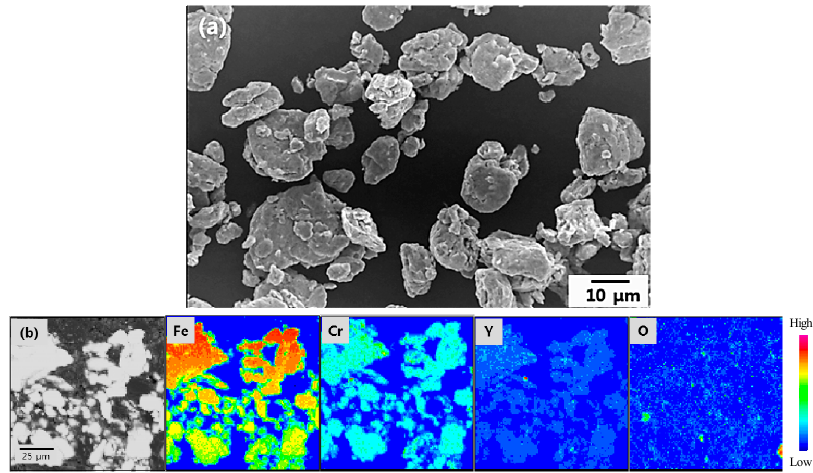
Figure 1. SEM (Scanning Electron Microscopy) and EPMA (Electron Probe Microanalysis) images of the mechanically alloyed Fe-10Cr-5Y 2 O 3 powders: ( a ) SEM and ( b ) EPMA mapping images. Metals 2020 , 10 , 310